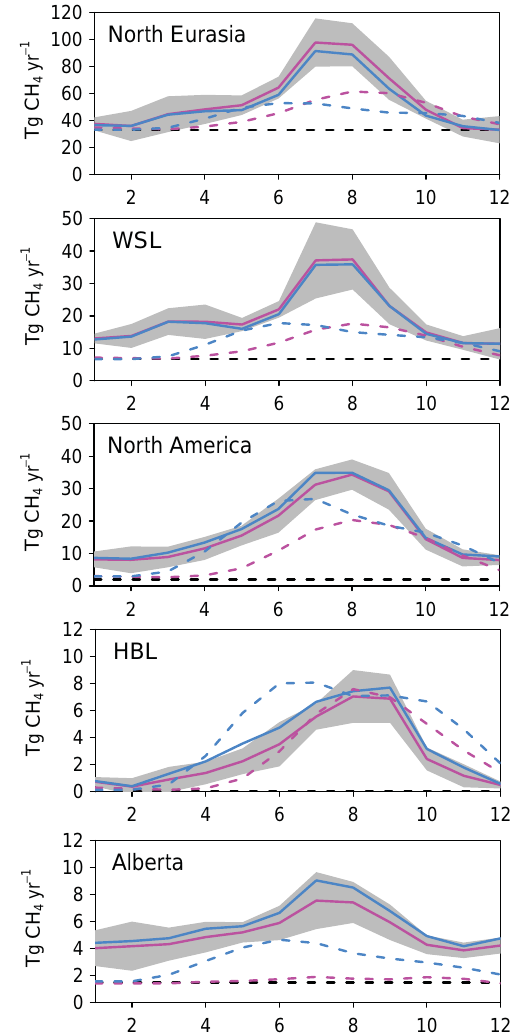
Figure 13. Inter-annual variability in CH 4 fluxes (units Tgyr − 1 ) for northern Eurasia, WSL, northern North America, HBL and Alberta. The inter-annual variability was calculated by subtracting the mean seasonal cycle (resolved monthly) from the time series for each re- gion and performing a running average on the residuals with a 6- month time window. The solid lines are the posterior fluxes from S1 (magenta), S2 (blue), and S3 (green); the dashed lines are the prior fluxes from S1 and S2. The shading indicates the posterior